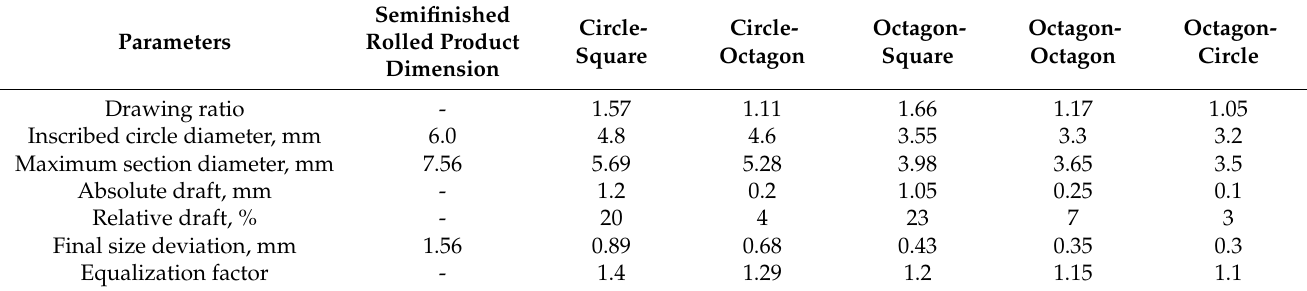
Table 2. Averaged Geometry Variation at Batch